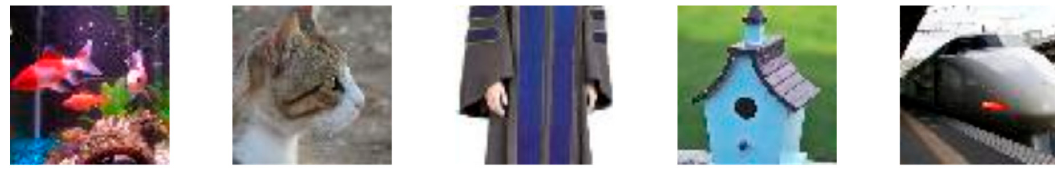
Figure 8. A sample of the ImageNet dataset.